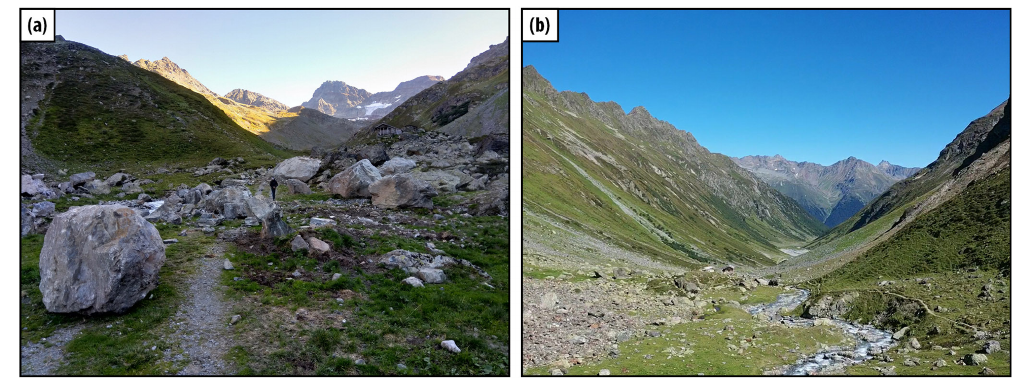
Figure A4. Laraintal. (a) Fresh rockfall deposits (2019) in the Zollhütte area. Note the person at the center of the photograph for scale. (b) Zollhütte area (L5) with unweathered scree on the left side of the photograph, a mass movement slab to the right of the hiking trail, and fresh rockfall path behind the slab.